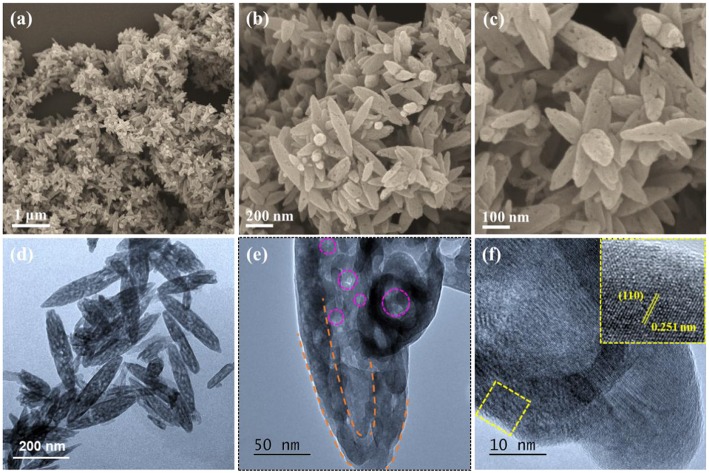
(a–c) FESEM, (d–f) HRTEM images of the Fe2O3-HMNS@CNT composite.